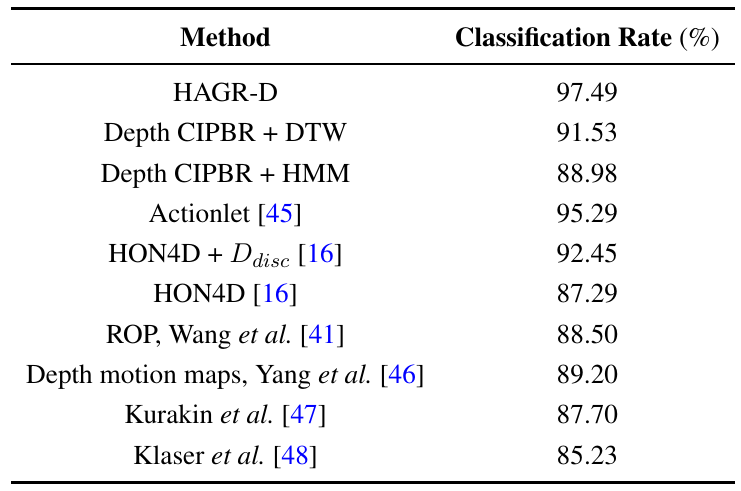
Table 4. Comparison between the results for MSRGesture3D with the leave-one-subject-out cross-validation as the classification